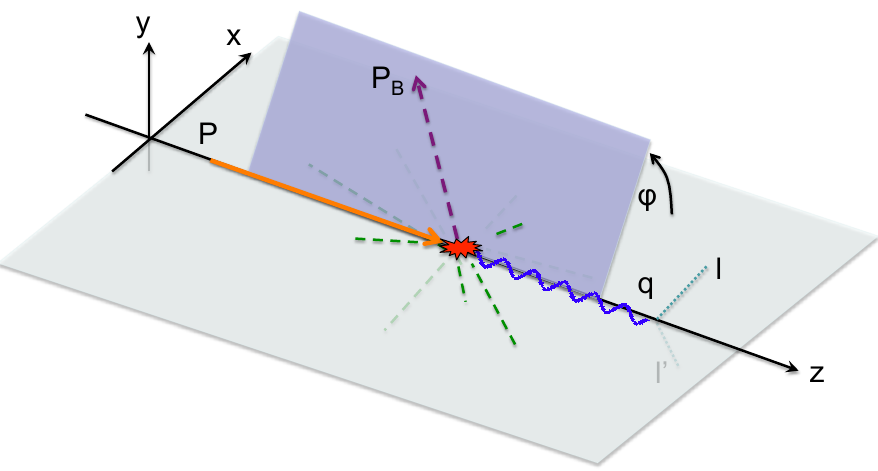
Figure 1 . The diagram of a SIDIS event in a photon frame. The hadron plane is shown in purple. The dashed green lines represent unobserved